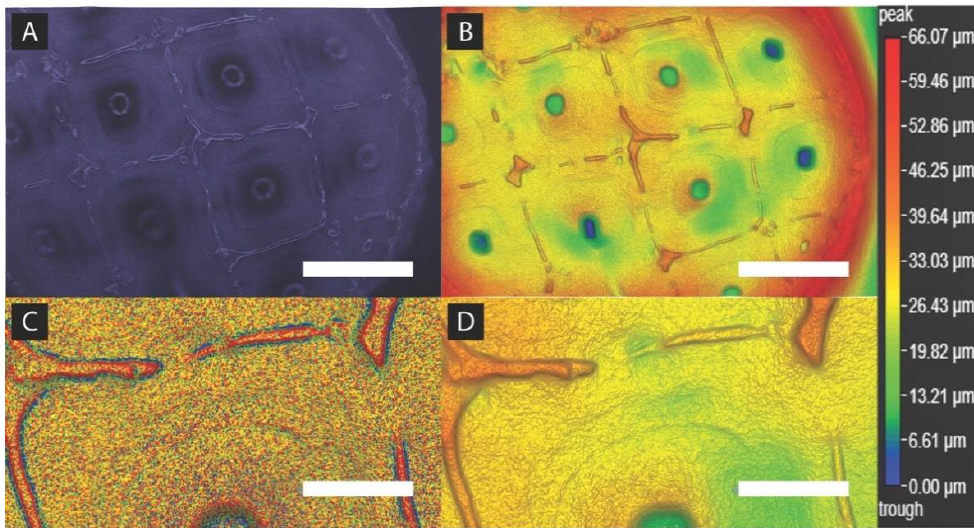
Figure 8. Computational analysis of MDA-MB-231 seeded scaffold surface. ( A ) Seeded basket true color dark field image at 5× objective (scale bar: 500 µm), ( B ) seeded basket colorized image for holistic/global height variation at 5× objective (scale bar: 500 µm), ( C ) seeded basket colorized image for localized height variation at 85% digital zoom and 5× objective (scale bar: 150 µm), ( D ) seeded basket colorized image for holistic height variation at 85% digital zoom and 5× objective (scale bar: 150 µm).